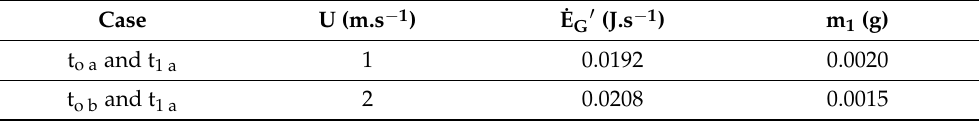
Figure 8. Values of t 1 (dehydration time) as a function of fuel moisture content x in tests with fuel bed ignition. The curves correspond to model predictions for: Case (a) U = 1 m.s − 1 and Case (b) U = 2 m.s − 1 . Table 5. Model parameters used in the cases illustrated in Figure